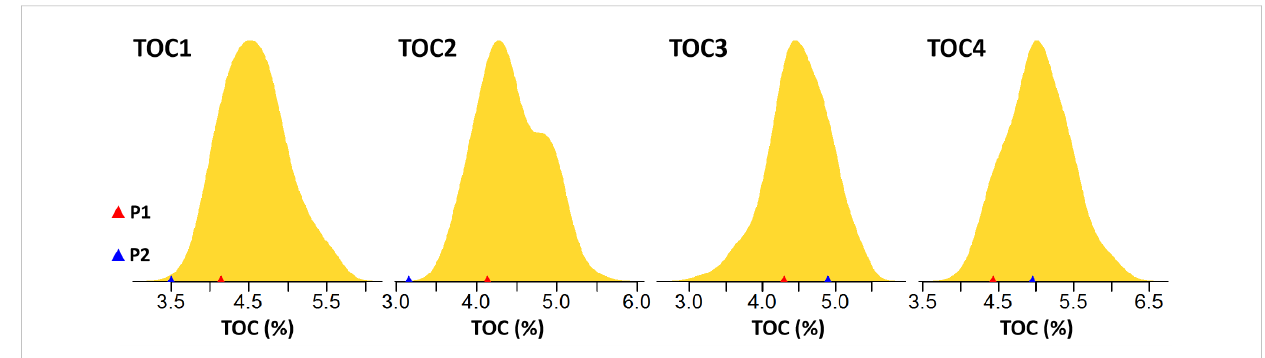
FIGURE 1 Phenotypic variation in TOC in the four DH populations. The x -axis showed the TOC and the triangle color indicated the TOC in